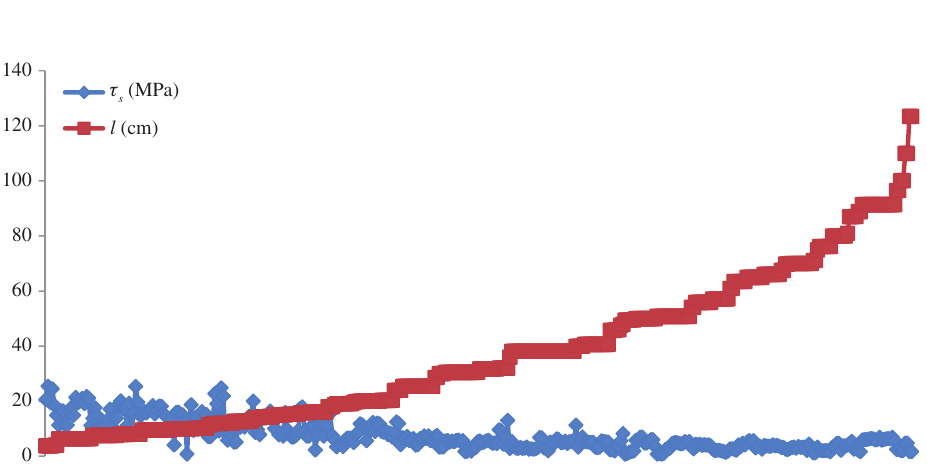
Figure 21: Change in the bond strength of FRP bars in concrete with changing concrete cover.